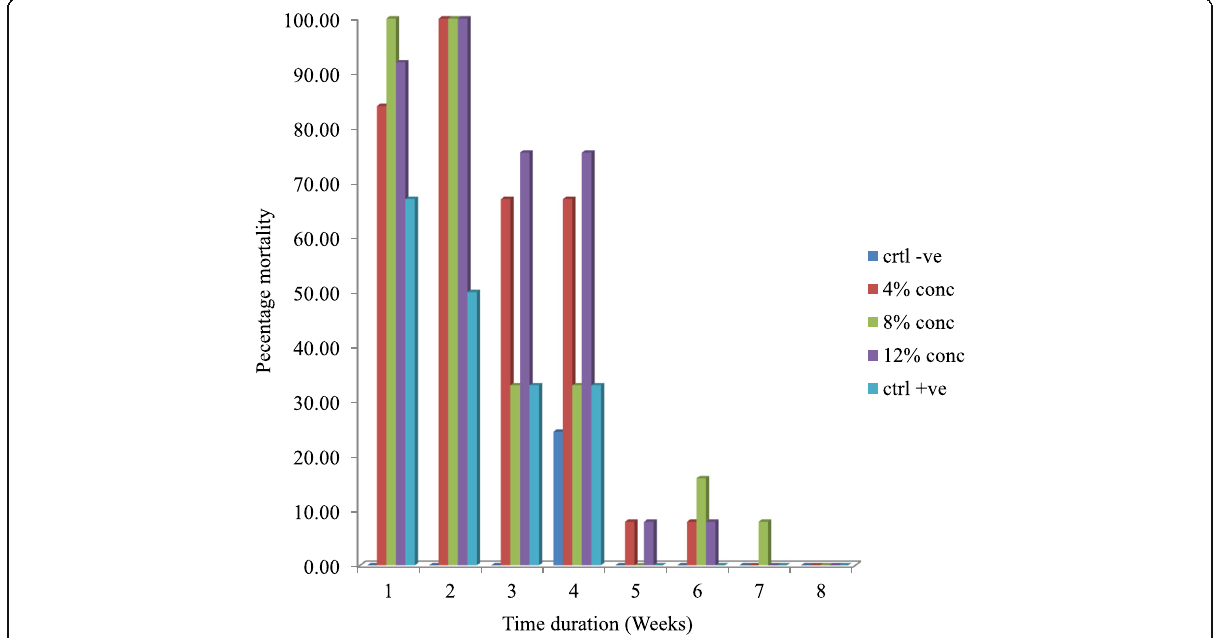
Fig. 3 Pesticidal effect of ethanolic extract of Capsicum